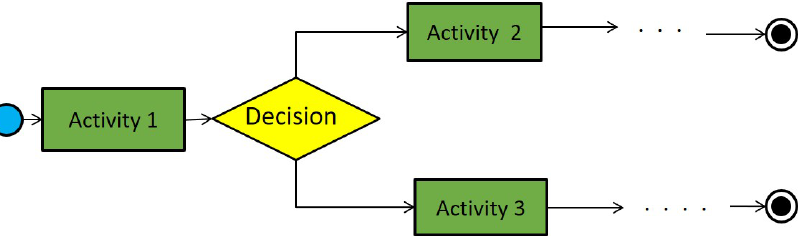
Figure 5. Behavioral mode of an